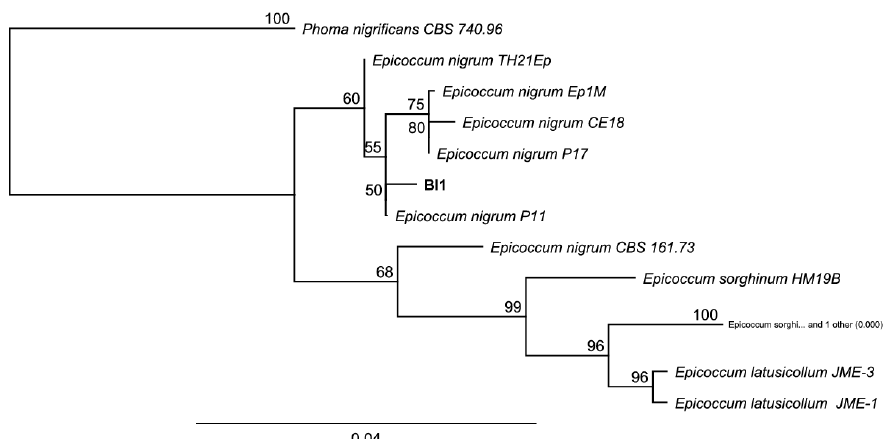
Figure 9. Neighbor-joining tree based on fungal tubulin sequences of Bl1 (Accession: OK319031), 11 Pleosporales species and Phoma nigrificans CBS 740.96 as outgroup. Numbers labeled at each node indicate bootstrap value (percentage) from 1000 replicates. Bar, 0.04 substitutions per nucleotide position.